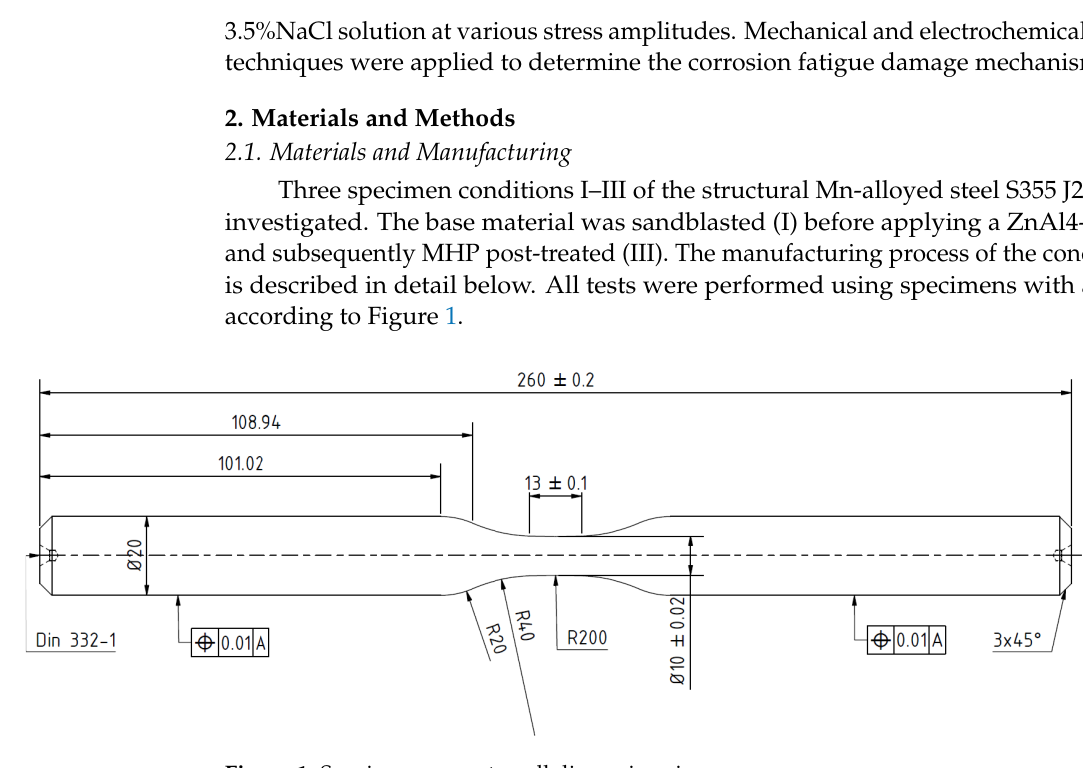
Figure 1. Specimen geometry, all dimensions in mm.